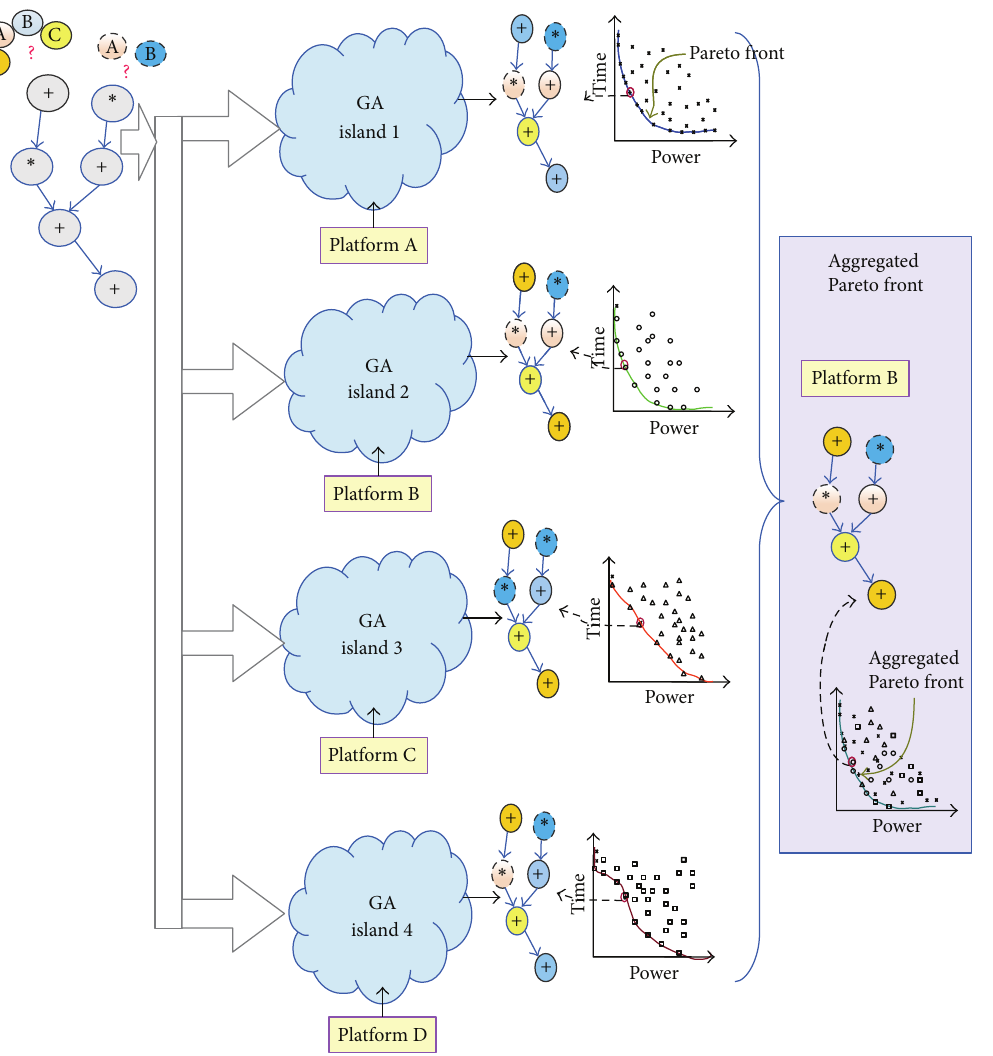
Figure 10: An Island Based GA (IBGA)